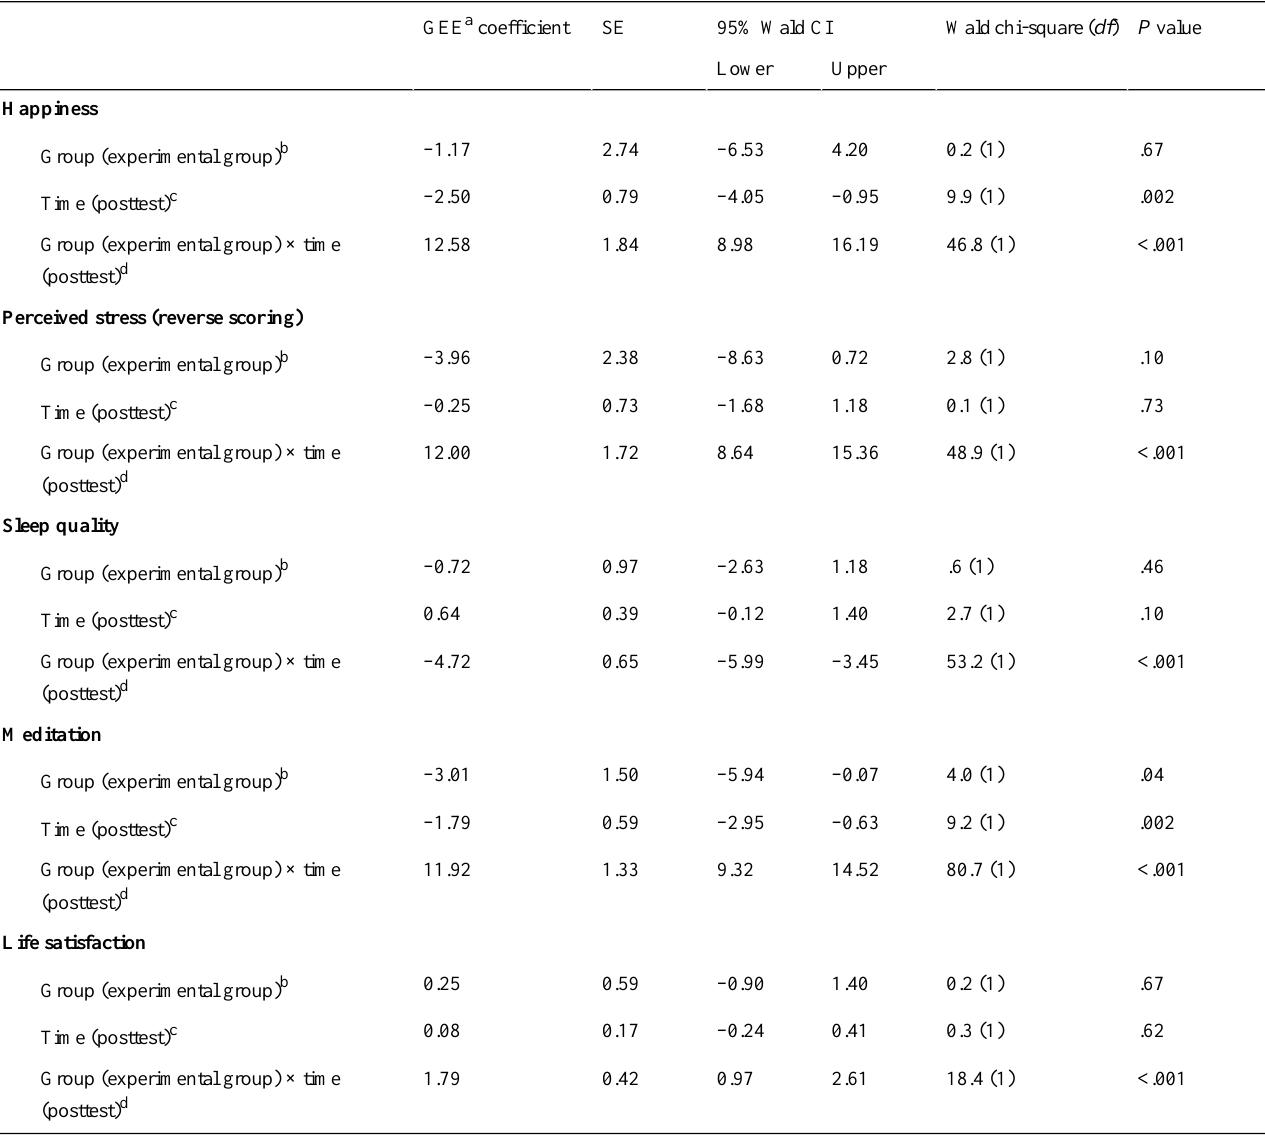
Table 1. Results of generalized estimating equation